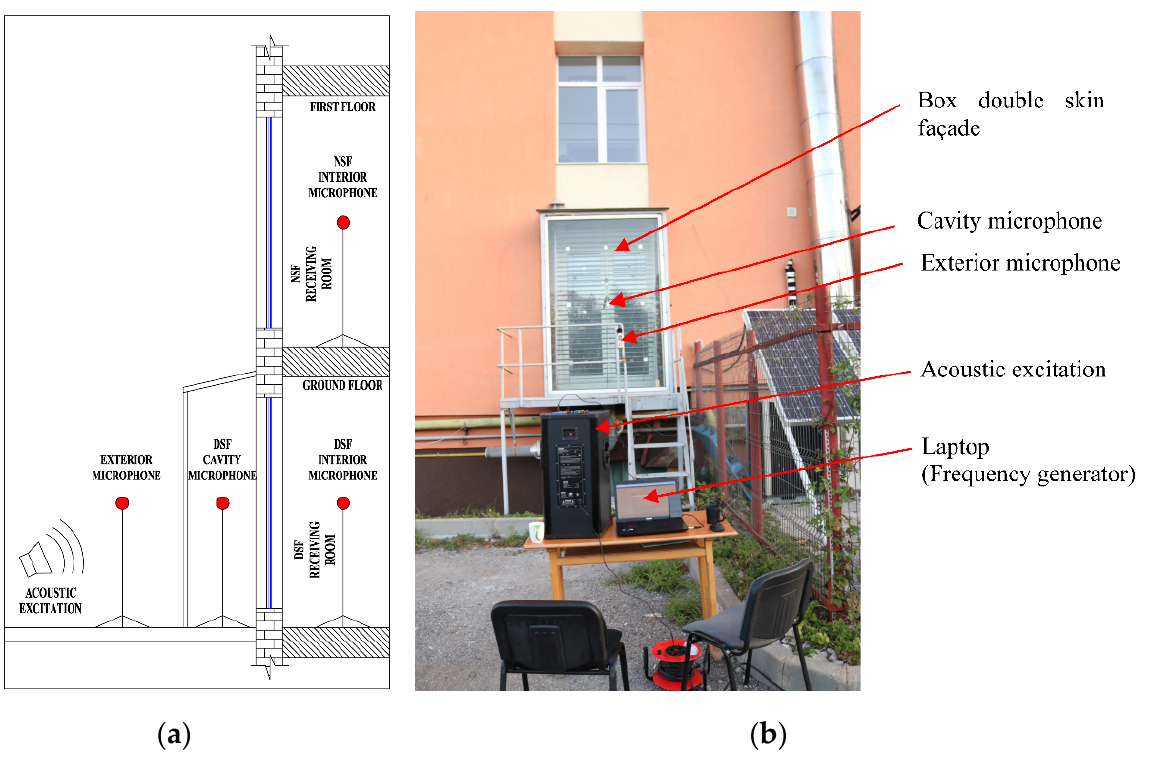
Figure 3. Scheme of the sound insulation measurement setup ( a ) and experimental setup viewed from outside ( b ).